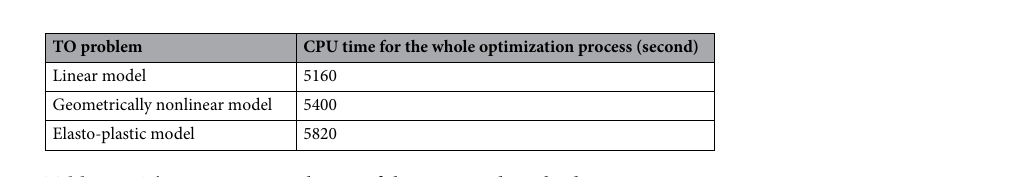
Table 12. The computational time of the proposed